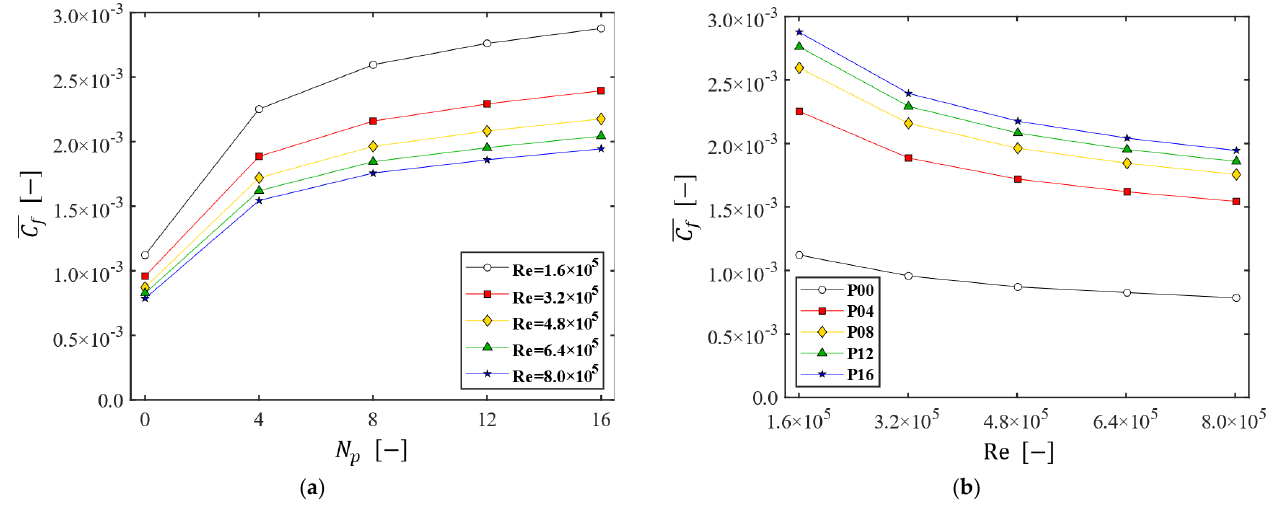
Figure 10. The change of the area-averaged friction coefficient ( 𝐶 𝑓 ̅̅̅ ). ( a ) 𝐶 𝑓 ̅̅̅ as a function of the numbers of patterns 𝑁 𝑝 at the five Reynolds numbers; ( b ) 𝐶 𝑓 ̅̅̅ as a function of the Reynolds number, affected by 𝑁 𝑝 .